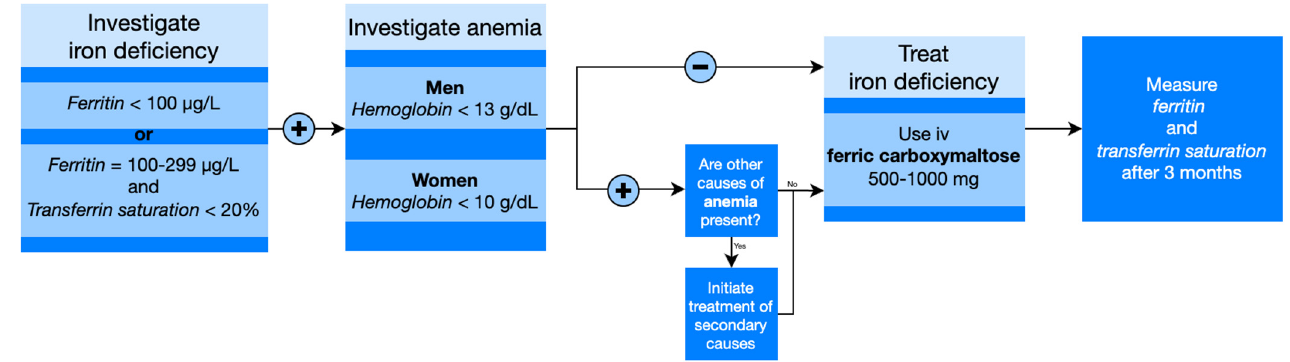
Figure 3. Therapeutical management of iron deficiency.